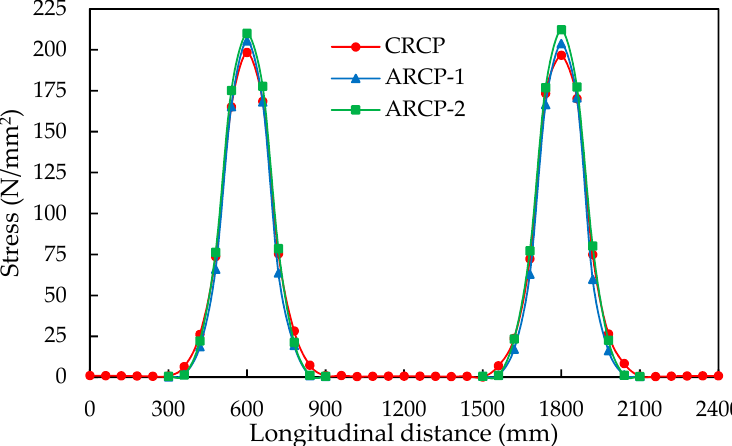
Figure 23. Comparison of maximum steel stress distribution between CRCP and ARCP.